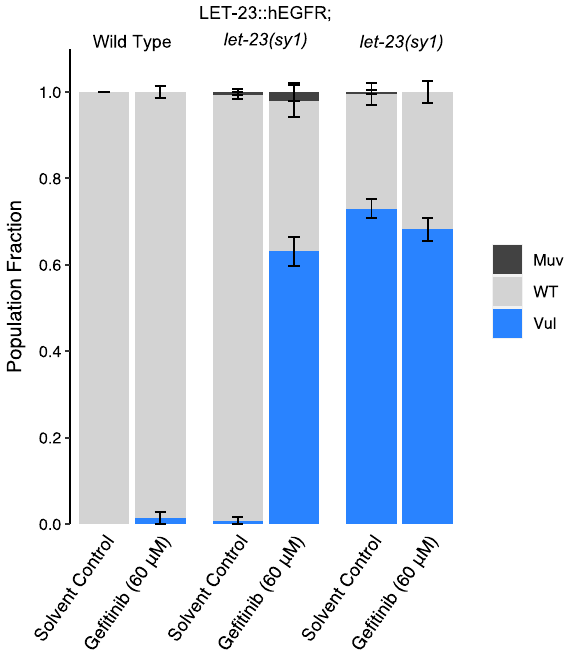
Figure 4. Structural divergence in EGFR/LET-23 impacts response to EGFR inhibitor gefitinib. The Vulvaless phenotype observed in the let-23(sy1) mutant is rescued by the expression of a chimeric protein whereby the kinase domain of LET-23 is replaced with human EGFR (LET-23::hEGFR). Gefitinib induces a vulvaless phenotype in the humanized strain, but not in wild type animals. DMSO is used as the solvent control. Error bars indicate